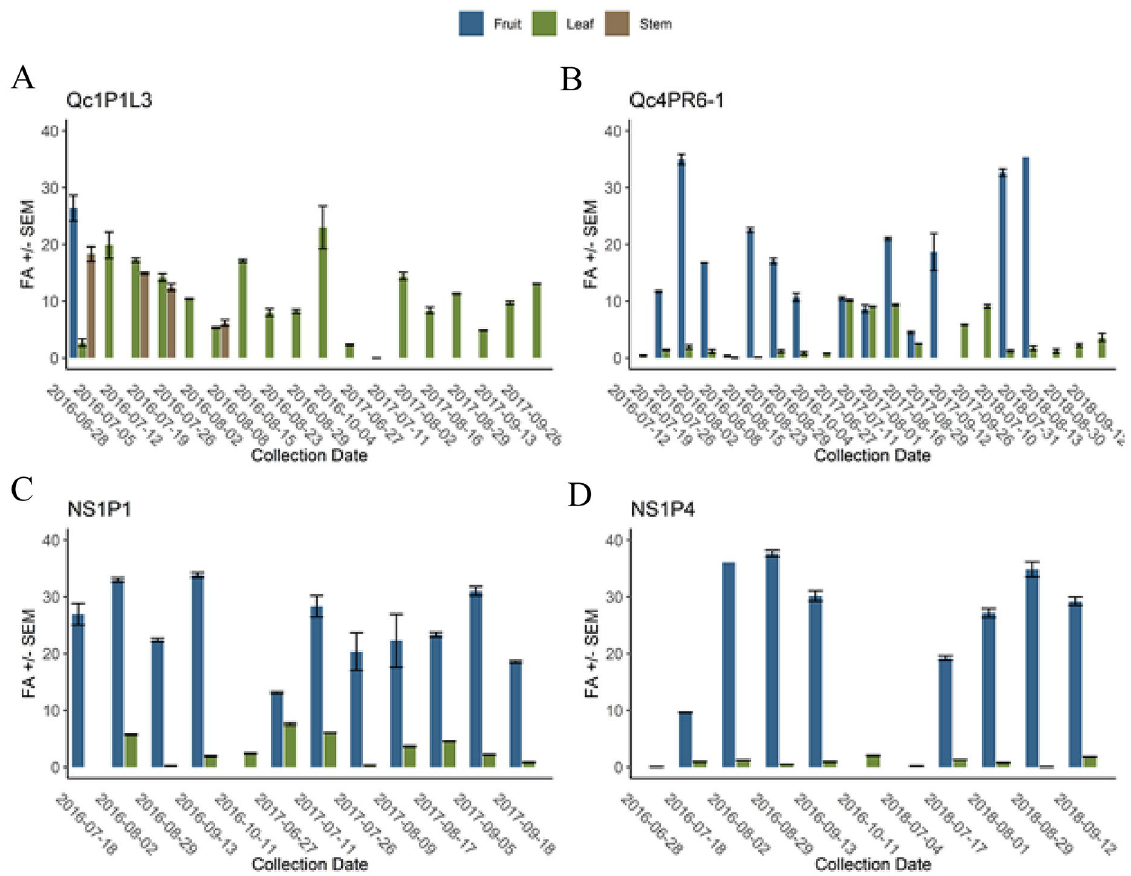
Figure 7. ddPCR results on highbush blueberry plants ( A ) Qc1P1L3 cultivar Blueray 2016 and 2017, ( B ) Qc4PR6-1 cultivar Blueray 2016, 2017 2018, ( C ) NS1P1 cultivar Liberty 2016 and 2017 and ( D ) NS1P4 cultivar Blue Gold 2016 and 2018. Fractional abundance in fruit (blue), leaves (green) and stem